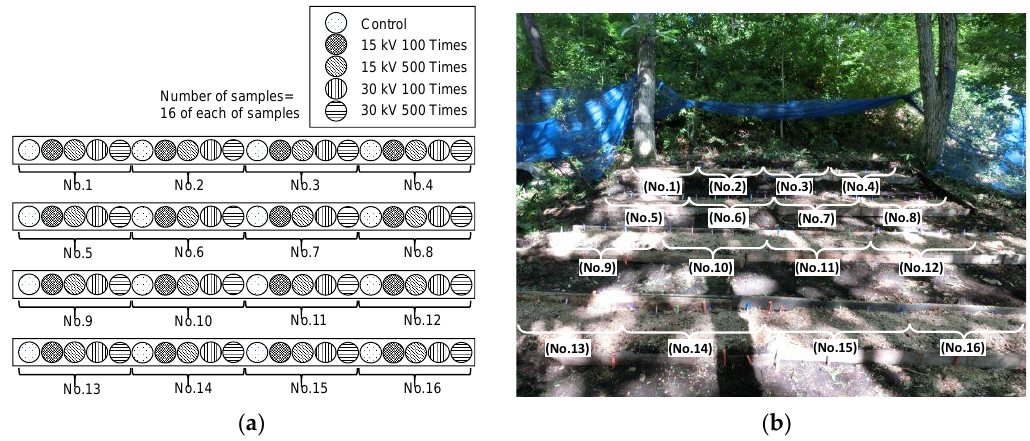
Figure 7. Arrangement ( a ) and photograph ( b ) of the Lyophyllum deeastes Sing. sawdust block for cultivation.